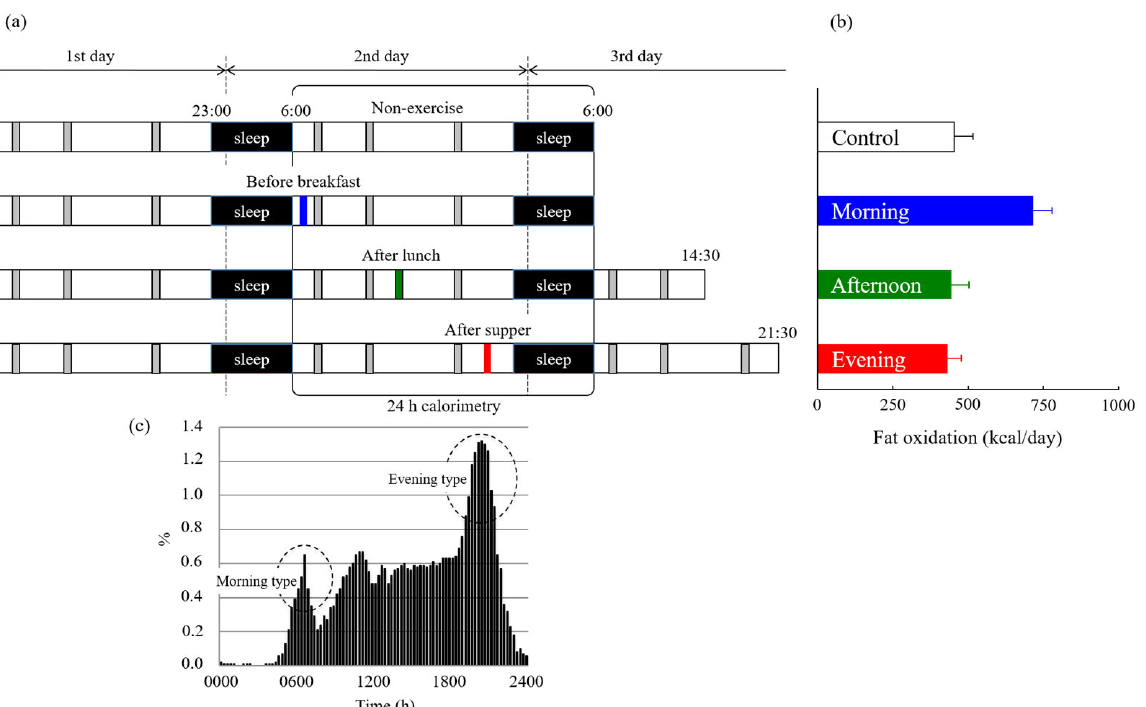
Figure 4. ( a ) Experimental protocol of our study [46]. Indirect calorimetry using a whole-room metabolic chamber was performed in 10 young non-obese men over 24 h. Participants remained sedentary (control) or performed 60 min of exercise at 50% VO 2max before breakfast (morning), after lunch (afternoon), or after supper (evening). All trials were designed to be performed in an energy-balanced state over 24 h. ( b ) Accumulated fat oxidation over 24 h following postprandial exercise was not higher than that in sedentary conditions. Only exercise before breakfast increased 24 h fat oxidation more than that in sedentary conditions. ( c ) Comparison of exercise timing in the study of diverse time use for sports, exercise, and recreational activities among Japanese